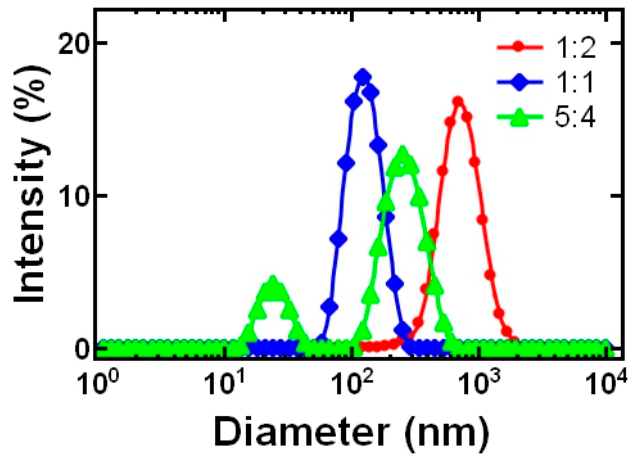
Figure 3. DLS results showing the effect of block copolymer:core (by mass) on tannic acid (TA)-chitosan nanoparticle size at a 1:1 ratio of TA:chitosan. Water was used as the solvent. Increasing the relative amount of block copolymer, i.e., changing the ratio from 1:2 (red) to 1:1 (blue) reduced particle size. Further increasing the relative amount of block copolymer ratio from 1:1 (blue) to 5:4 (green) resulted in the formation of TA-chitosan nanoparticles and empty micelles. The mass ratio of TA:chitosan was held constant at 1:1.